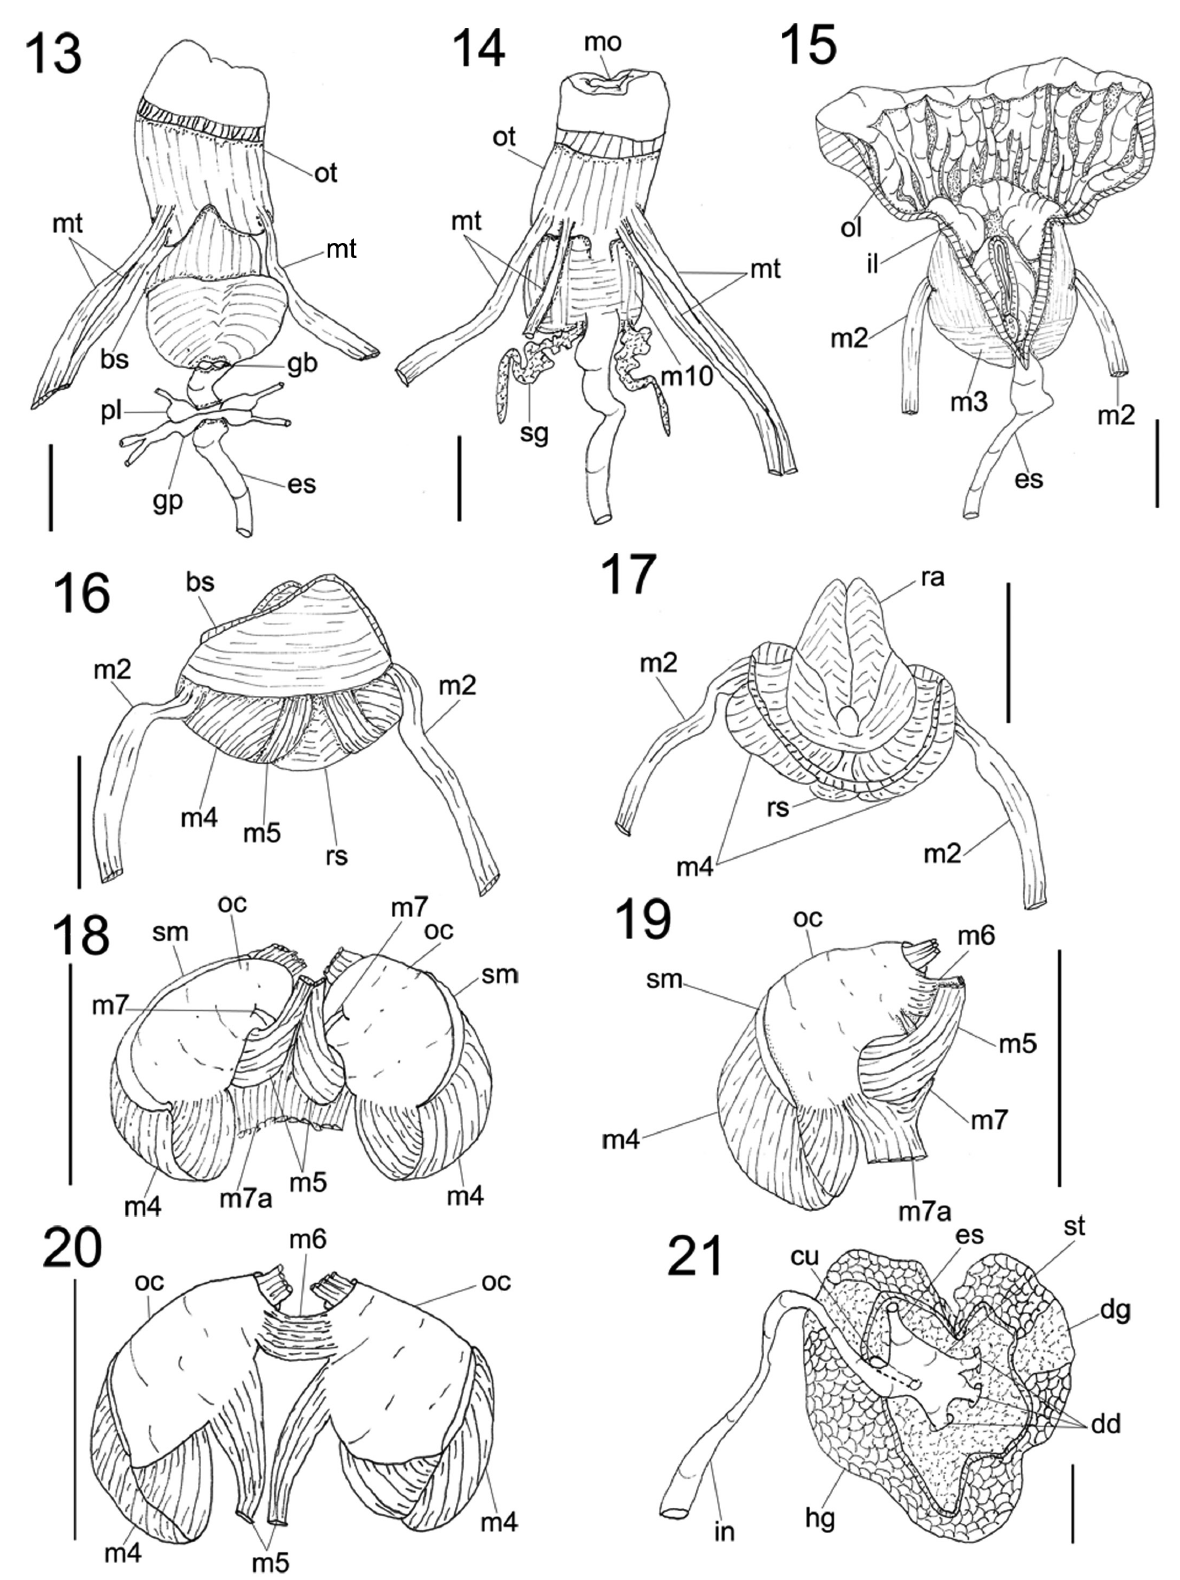
Figures 13–21. Actinocyclus verrucosus details of digestive system. 13. Foregut and nerve ring, ventral view, some adjacent struc- tures also shown as in situ, scale: 1 mm. 14. Same dorsal view, scale: 1 mm. 15. Same, longitudinally sectioned, showing internal oral tube, dorsal view, scale: 1 mm. 16–20. Odontophore anatomy, scales: 1 mm . 16. Whole ventral view, sphincter removed. 17. Whole dorsal view, esophagus removed. 18. Dorsal view, radula removed, each cartilage slightly deflected. 19. Whole right view. 20 . Ventral view, m4 and m5 folded down to expose odontophore cartilage; m7 and m7a removed. 21. Midgut as in situ, dorsal view, scale: 2